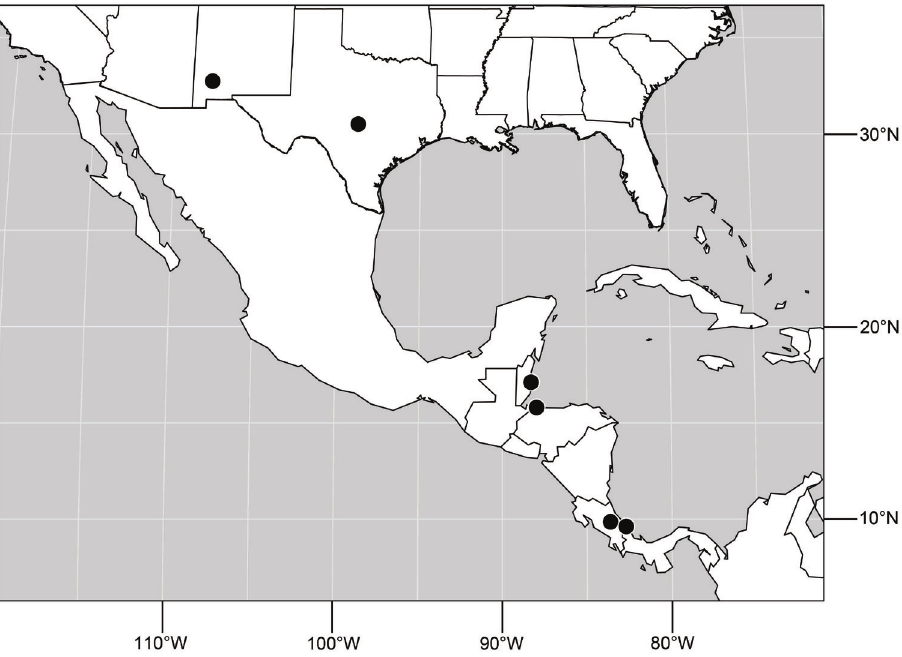
Figure 61. Distribution of Hydrochasma williamsae sp.